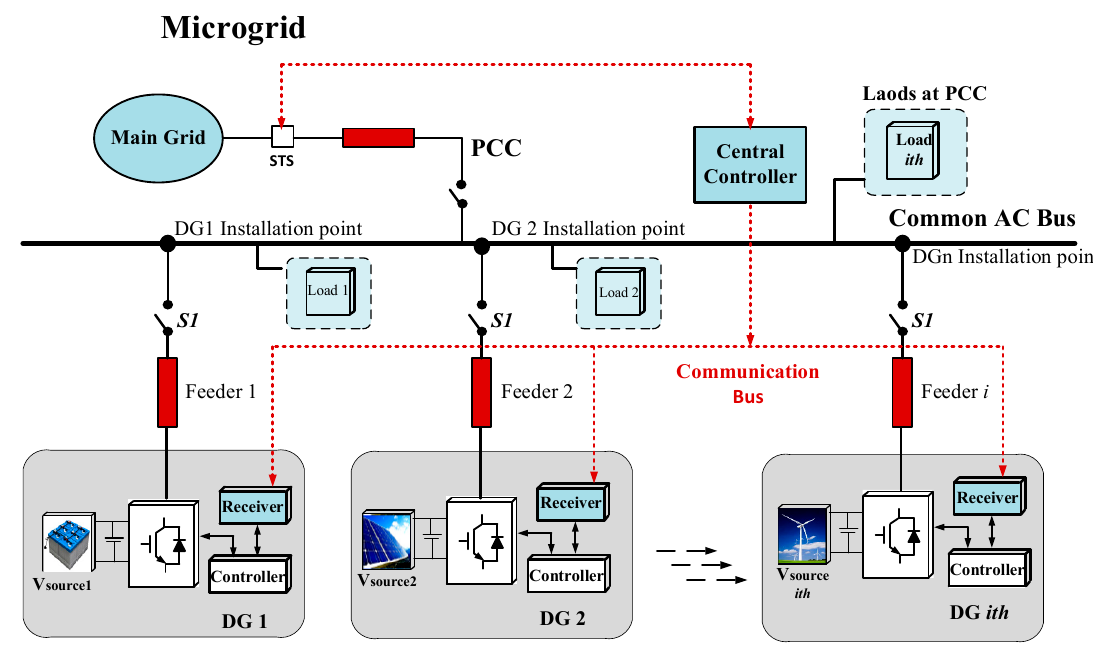
Figure 1. Illustration of the microgrid configuration. Red arrow used as communication link.